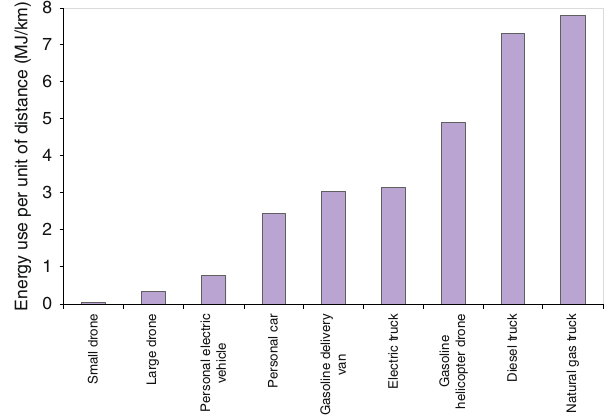
Fig. 4 Energy required per km of travel for individual package delivery vehicles. Electric drone and electric vehicle energy use shown includes losses in transmission, distribution, and charging. Electrical conversion losses at the power plant not shown, but are included for the emissions analysis. Energy use per package delivery is dependent on number of packages per km, in addition to a range of vehicle and route